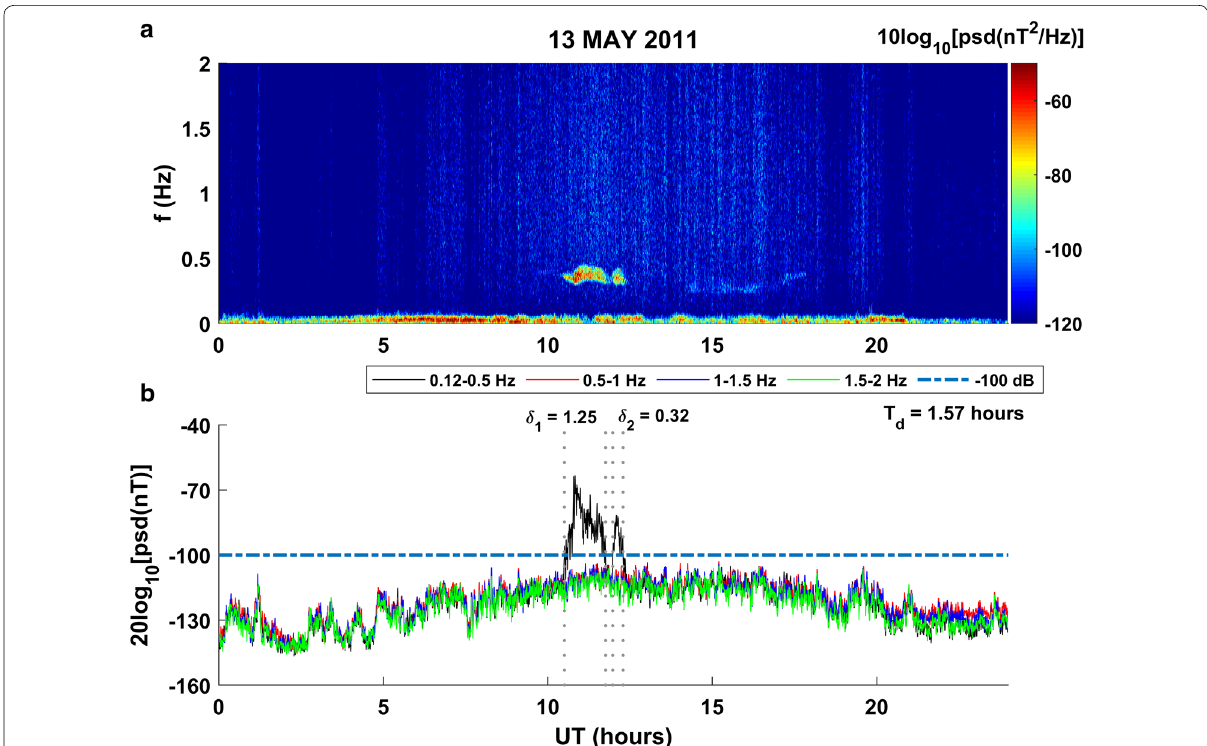
Fig. 1 a The spectrogram of total magnetic field variation, and b corresponding plot of averaged powers for different frequency bins are depicted as a function of universal time (UT LT-0.77 h) for EMIC wave activities observed on 13 May 2011. The intervals of EMIC wave activities are indicated = in the lower panel and they are marked with black dotted vertical lines. δ 1 and δ 2 represent the durations of occurrences of EMIC waves in frequency bin f 1 (0.12–0.5 Hz). The total EMIC wave duration for this day is 1.57